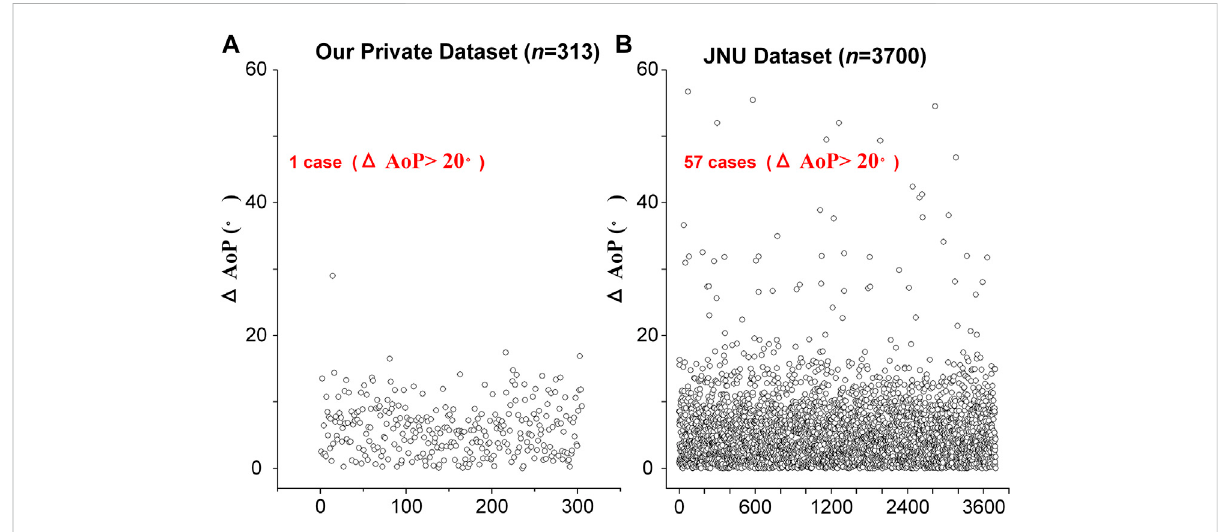
FIGURE 4 The distribution of AoP difference ( Δ AoP) between the predicted AoP and the GT ’ s AoP. (A) There is one case with Δ AoP > 20 ° in our private dataset ( n = 313). (B) 57 cases with Δ AoP > 20 ° in the public dataset ( n > 3,700).